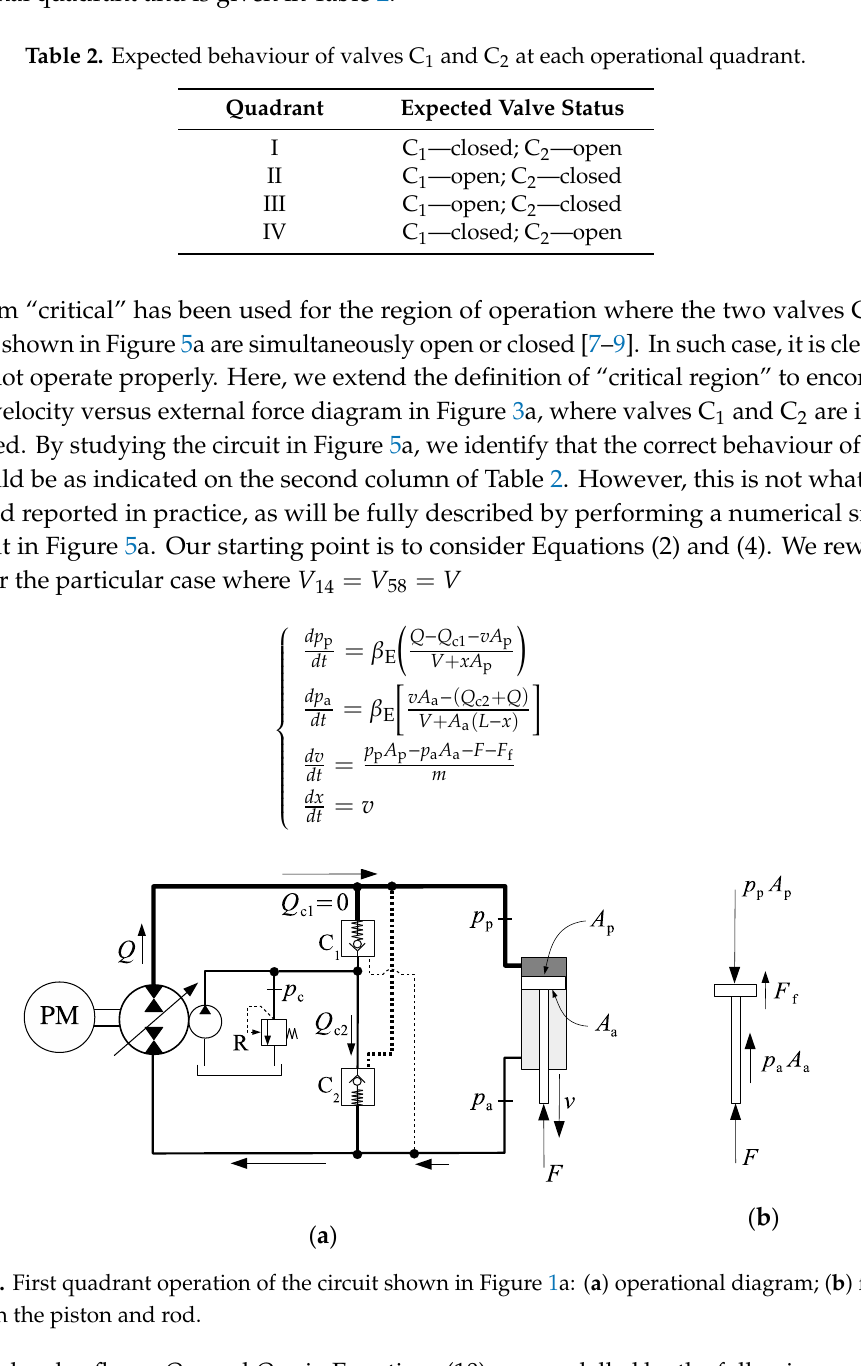
Table 2. Expected behaviour of valves C 1 and C 2 at each operational quadrant.